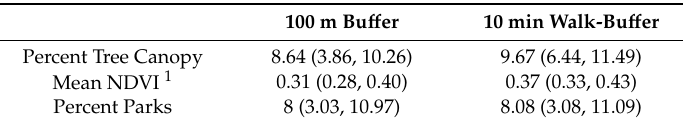
Table 1. Percent of di ff erent metrics of greenspace in two di ff erent types of bu ff ers. Figures in brackets show the 25th and 75th percentiles.